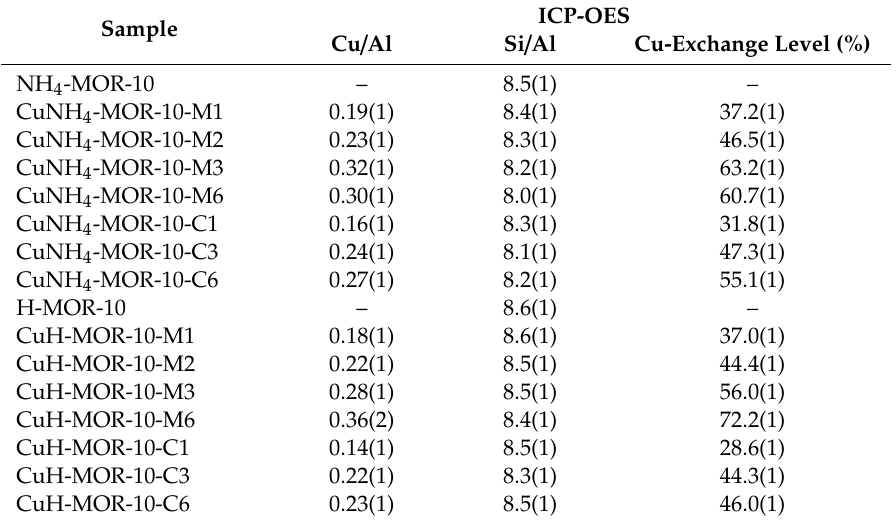
plasma-optical emission spectroscopy (ICP-OES)